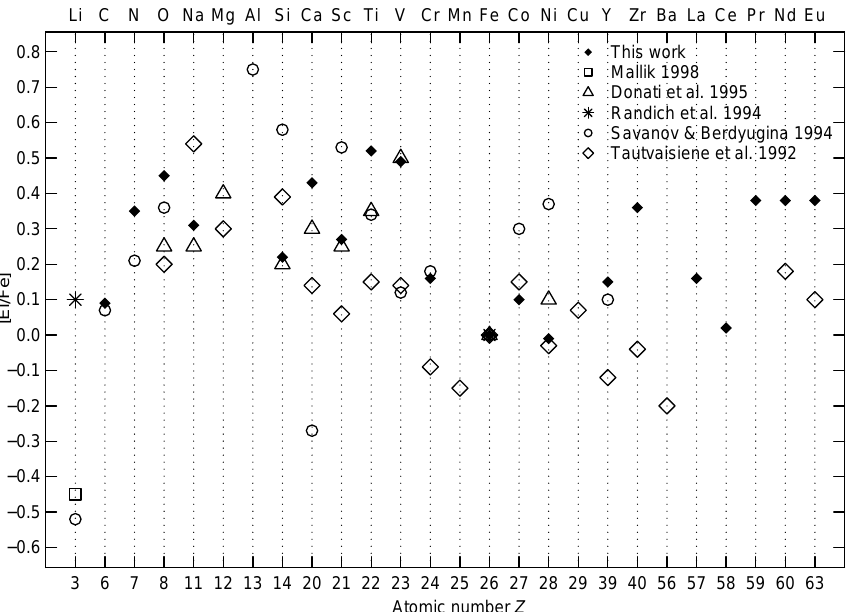
Fig. 7. Abundances of elements for (cid:21) And, as determined in this work (filled di- amonds), Donati et al. (1995, triangles), Savanov & Berdyugina (1994, circles), Taut- vaiˇsien˙e et al. (1992, empty diamonds). The [Li/Fe] value from Randich et al. (1994) is shown as an asterisk and from Mallik (1998) as a